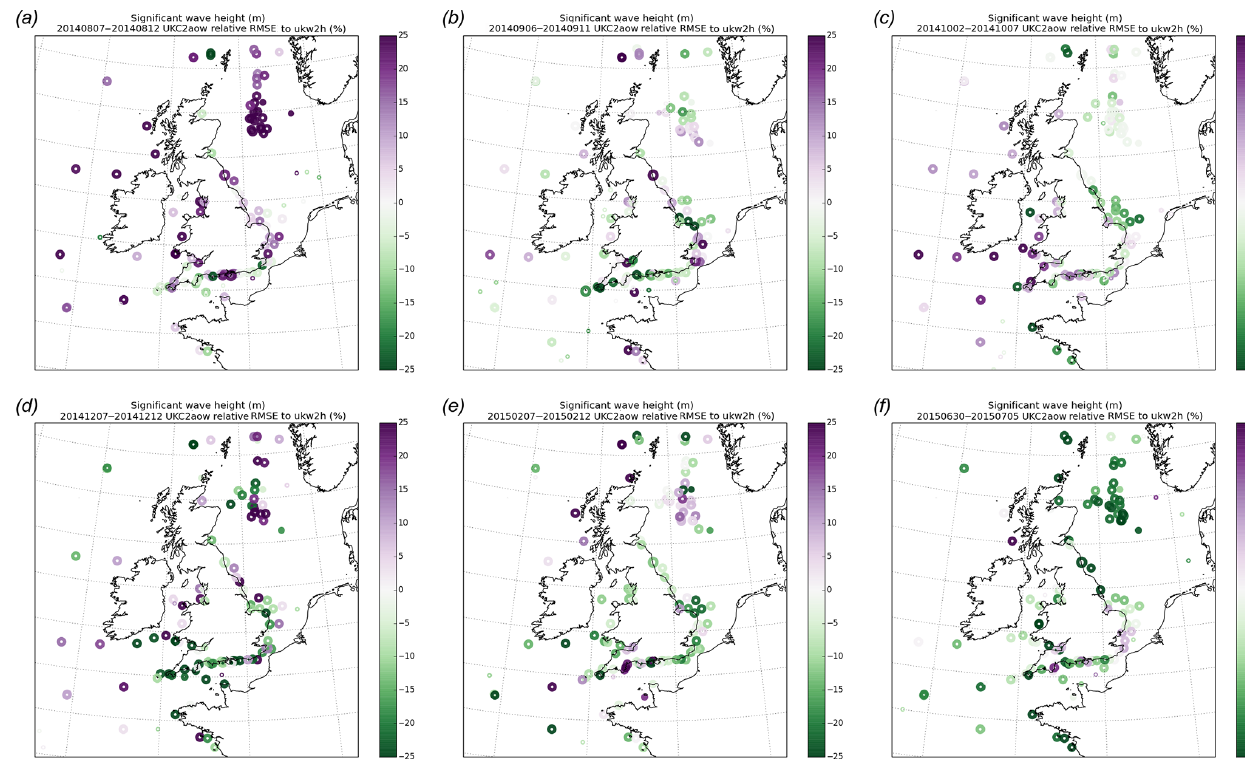
Figure 13. Differences in case study wave model RMSE statistics for significant wave height, comparing statistics computed for the fully cou- pled UKC2aow simulation as a % difference relative to the wave-only UKW2h runs with high-resolution wind forcing. Green sites indicate an overall reduction in RMSE relative to the control. Results are shown for 5-day case study periods in (a) August 2014, (b) September 2014, (c) October 2014, (d) December 2014, (e) February 2015 and (f) July 2015. RMSE statistics are computed by comparing UKC2aow and UKW2h model outputs with in situ observations. Note that only an inner section of the domain is presented for